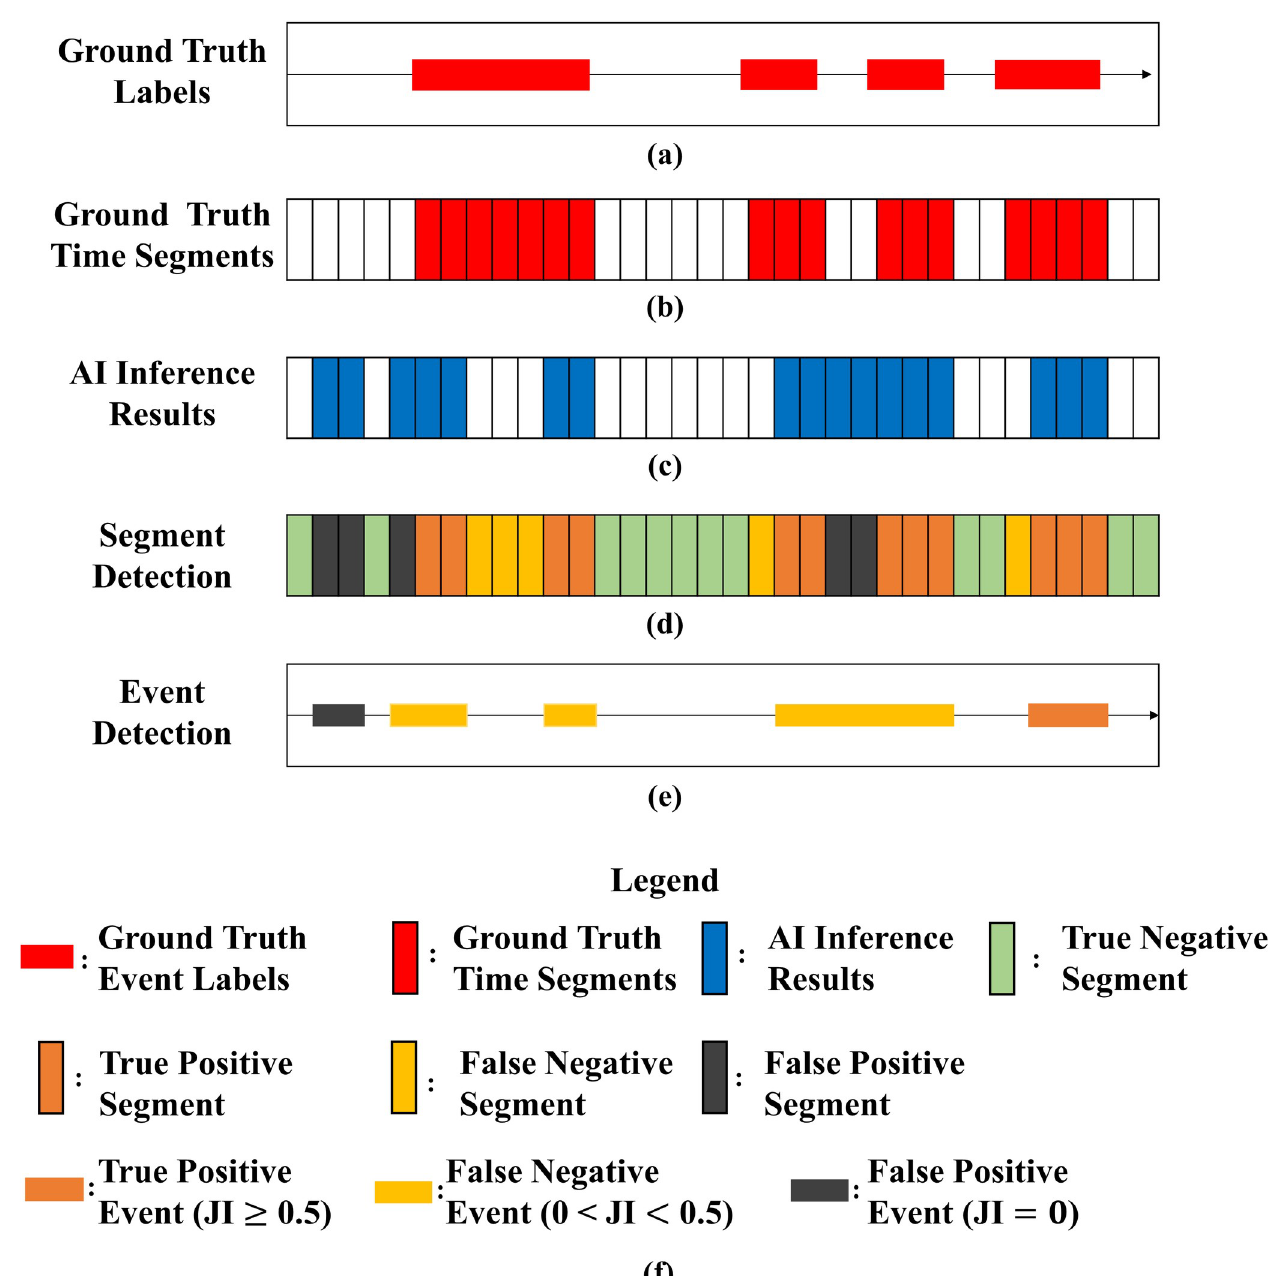
Fig 6. Task definition and evaluation metrics. (a) Ground-truth event labels, (b) ground-truth time segments, (c) AI inference results, (d) segment classification, (e) event detection, and (f) legend. JI: Jaccard index.